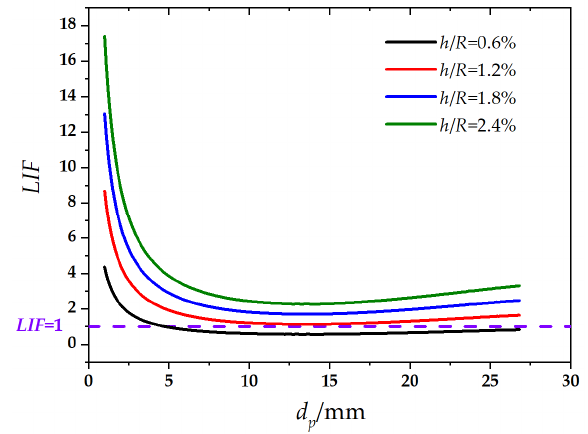
Figure 13. Relation between lift index and particle diameter under four different h / R .